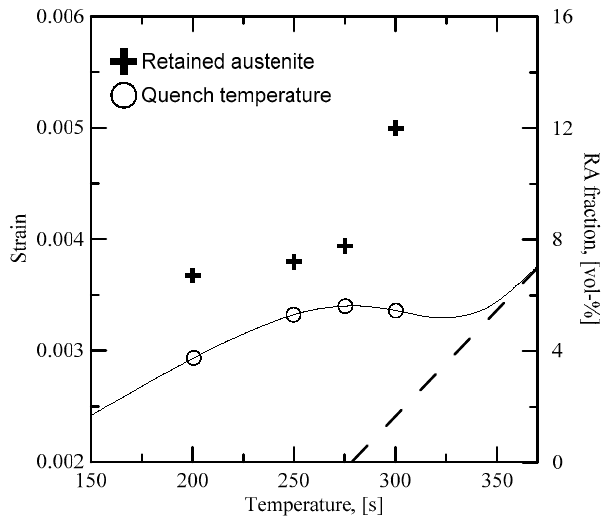
Figure 13. The dilatation curve of Steel B in the regime of martensite transformation, with the retained austenite content with respect to the initial quench temperature QT on the secondary y -axis.